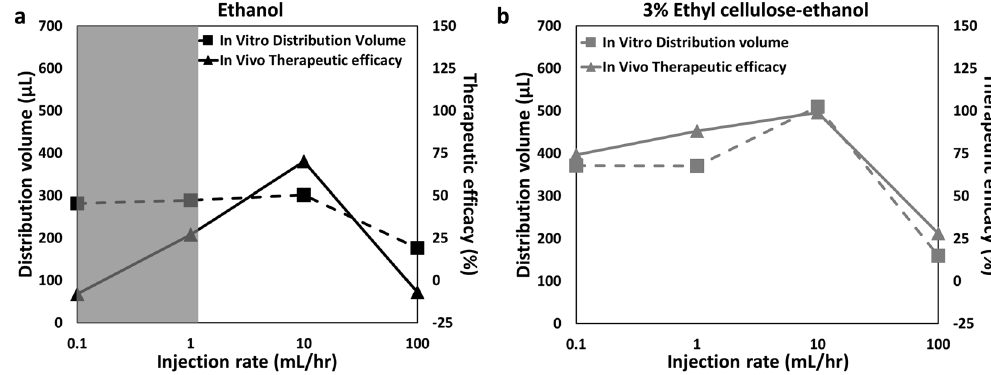
Figure 8. In vivo tumor ablations and in vitro tissue phantom distribution volumes have comparable results. In vivo therapeutic efficacy is defined as (1 – normalized tumor volume at day 7). In vitro tissue phantom distribution volumes were measured at rates used for the in vivo tumor ablations. ( a ) For ethanol injection, therapeutic efficacy did not correlate with distribution volume in injection rate-matched phantoms (Pearson’s correlation coefficient = 0.62, exact p-value = 0.382, t-value = − 1.112, degrees of freedom = 2). The shaded area represents the injection rates that are approximately equal to the vascular clearance rates, likely reducing the accumulation rate within the tumor. ( b ) In contrast, for ethyl cellulose, the correlation was substantially higher (Pearson’s correlation coefficient = 0.96, exact p-value = 0.0352, t-value = 5.184, degrees of freedom =